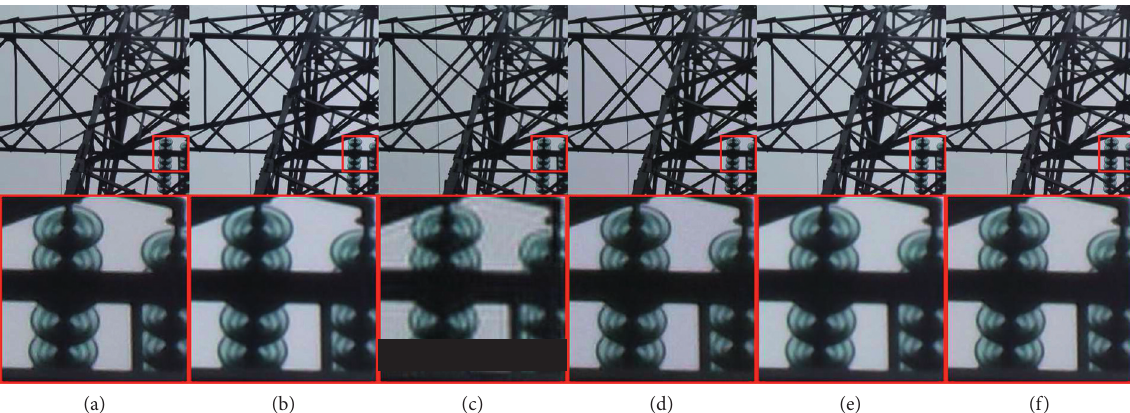
Figure 3: Super-resolution results of the power image with magnification factor 2: (a) original high-resolution image; (b) result reconstructed by SRCNN; (c) result reconstructed by FSRCNN; (d) result reconstructed by SRGAN; (e) result reconstructed by RDN; (f) result reconstructed by our